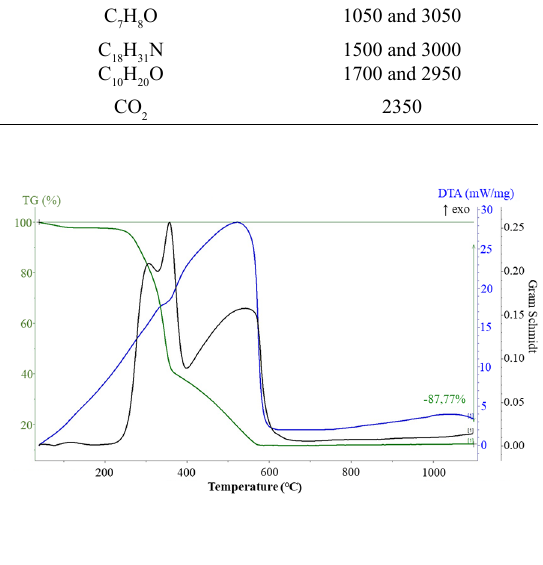
Figure 7. Thermogravimetric and differential thermal analysis of jute fiber.